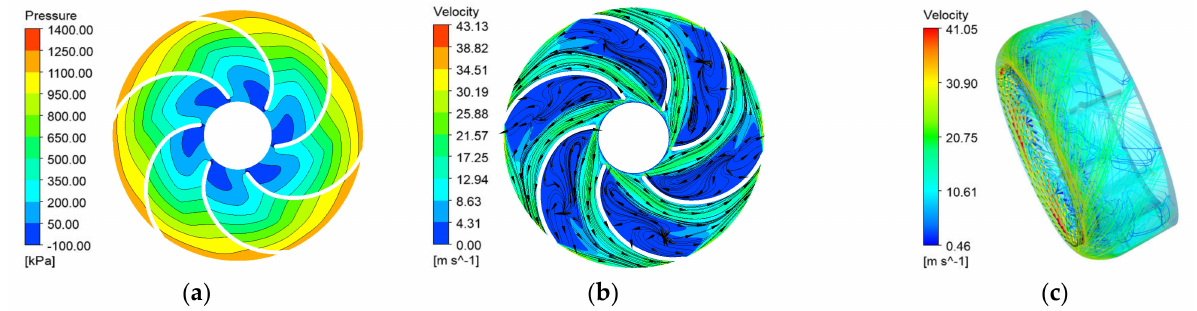
Figure 3. Analysis of the internal flow field of the impeller and the guide vanes. ( a ) Pressure cloud diagram of the midsection of the impeller. ( b ) Velocity streamline diagram of the midsection of the impeller. ( c ) Velocity streamline diagram of guide